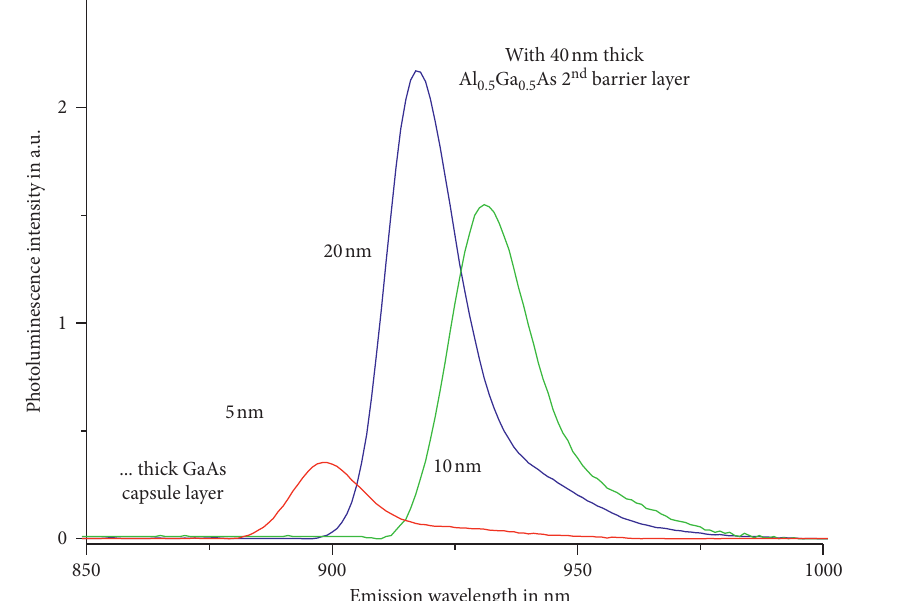
Figure 9: Results of photoluminescence (PL) measurements for three different samples, each with 4 QD layers, but double-layer barriers. Each barrier is made from a 5nm, 10nm, and 20nm thick GaAs capsule layer, respectively, and a 40nm thick Al 0.5 Ga 0.5 As layer. The QD layers have been grown as described above; see Figure 6.